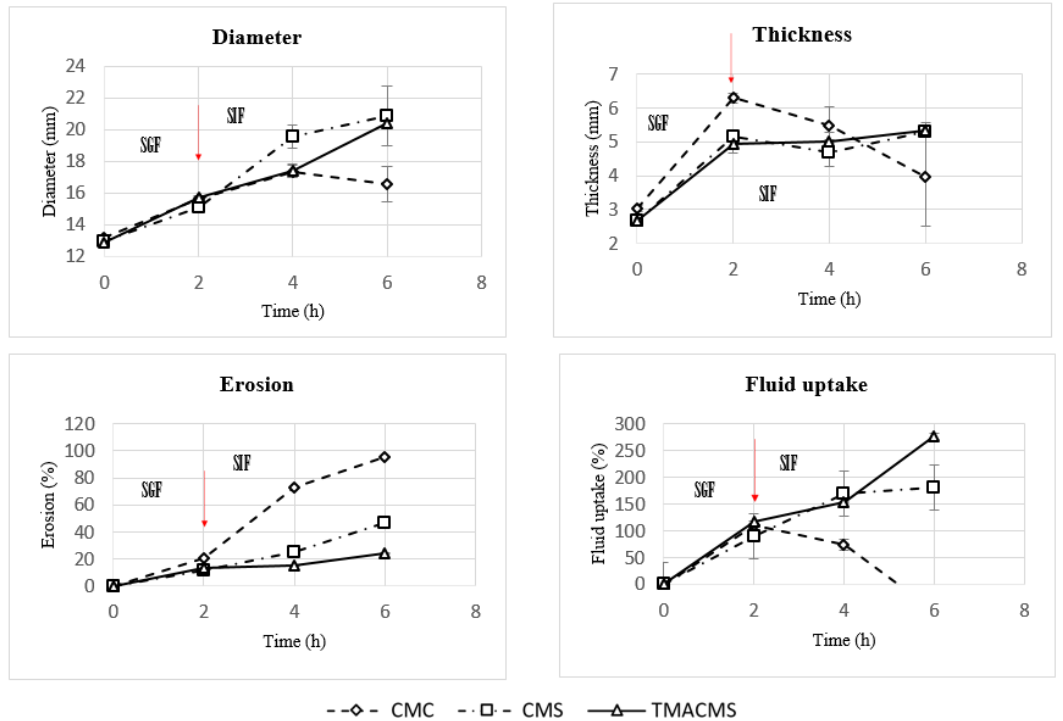
Figure 7. Diameter, thickness, erosion, and fluid uptake changes of tablets of CMC, CMS, and TMACMS tablets containing 30% catalase. Tablets were incubated in SGF for 2 h and, then, were transferred to SIF at T = 2 h. The arrows mark the transitions from SGF to SIF.